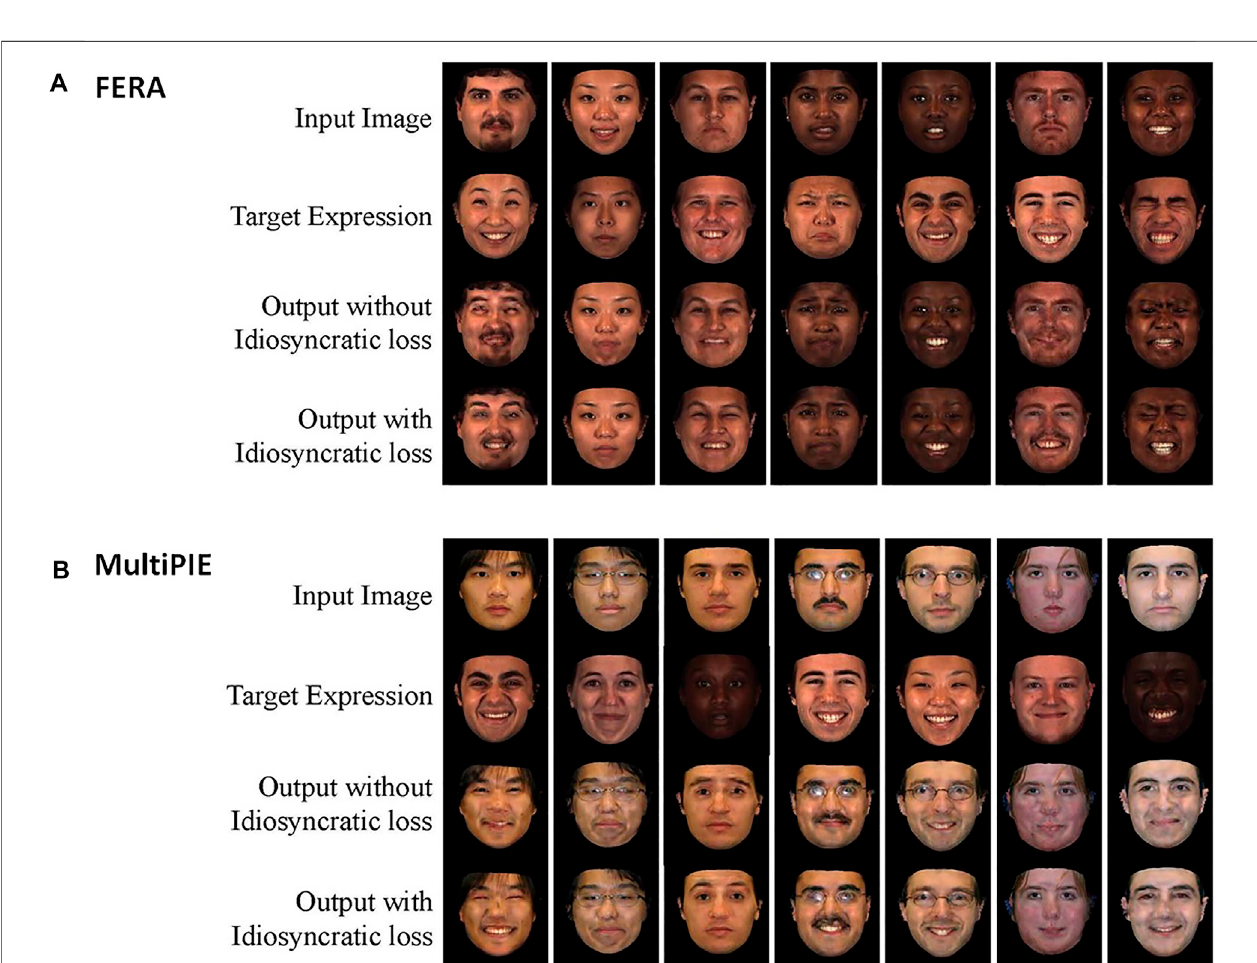
FIGURE 4 | Comparison without and with idiosyncratic loss on (A) FERA and (B) MultiPIE.